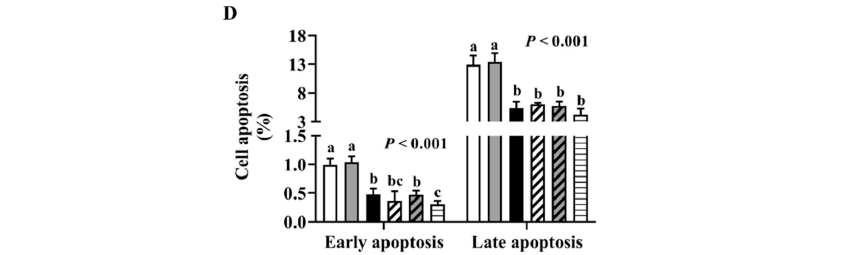
Figure 8. CHOP interference can resist RD-induced cell apoptosis. Effect of CHOP interference on cell number ( A ) and relative cell viability ( B ) in riboflavin-deficient cells. Each treatment is performed in six replicates ( n = 6). ( C ) Effect of RD on cell apoptosis following treatment with CHOP siRNA in HepG2 cells. ( D ) Results of cell apoptosis analysis. Different letters indicate significant differences ( p < 0.05). Each treatment is performed in three to six replicates ( n = 3~6).